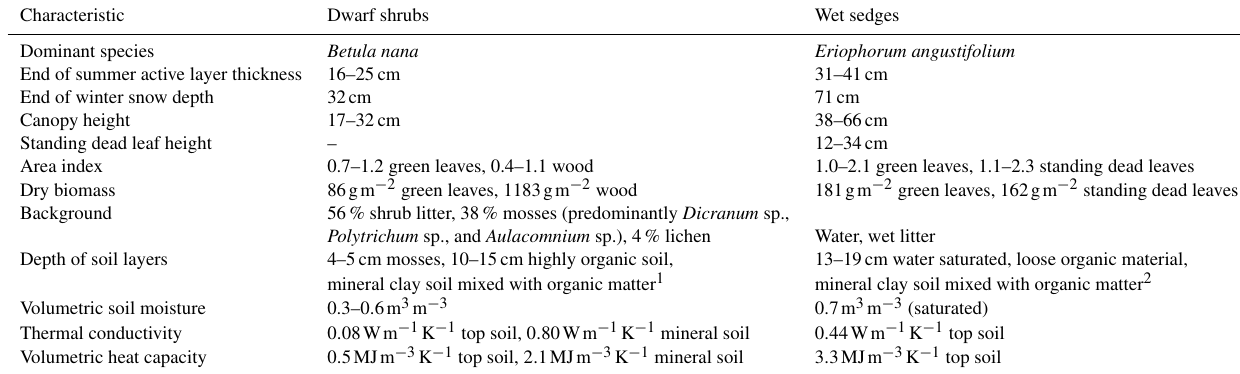
Table 1. Vegetation and soil characteristics of dwarf shrubs and wet sedges; all data were collected in our study, except the depth of soil layers; the measurements are described below in the methods section; the dwarf shrub area index is the projected area index adjusted by the average measurement